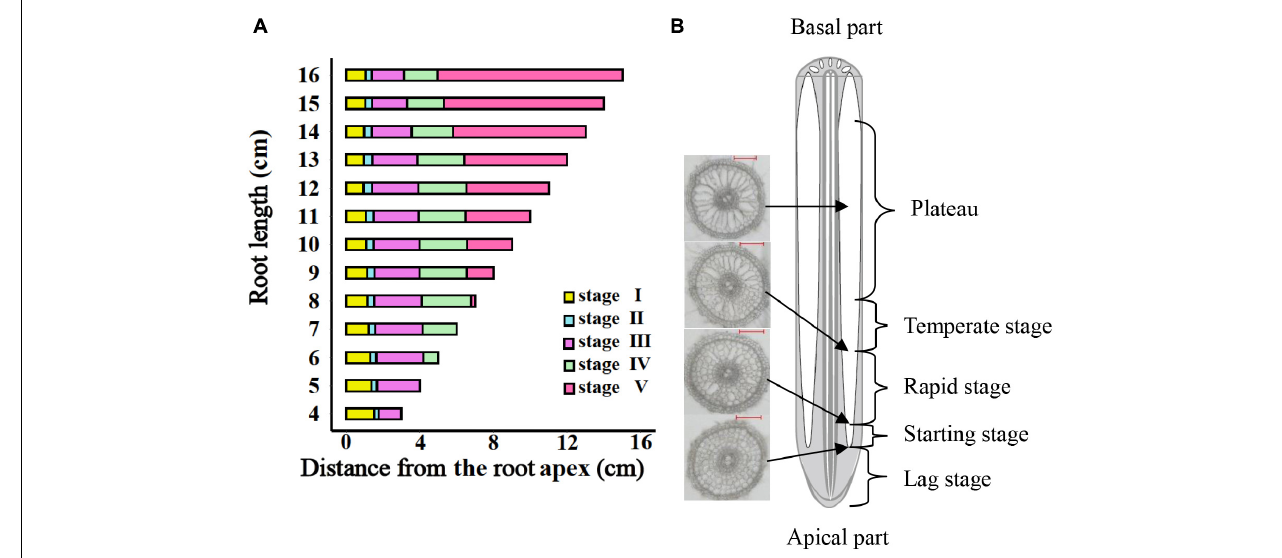
FIGURE 6 | The entire period of aerenchyma formation in rice roots. (A) Five stages of aerenchyma formation divided according to the critical points of the Ti-Gompertz model. (B) The longitudinal pattern of a typical rice root. Stage I: the lag stage; Stage II: the starting stage (from the initial point to maximum acceleration); Stage III: the rapid stage (from maximum acceleration point to maximum deceleration point); Stage IV: the temperate stage (from maximum deceleration point to 95% maximum value point); and Stage V: the plateau (upper asymptote).